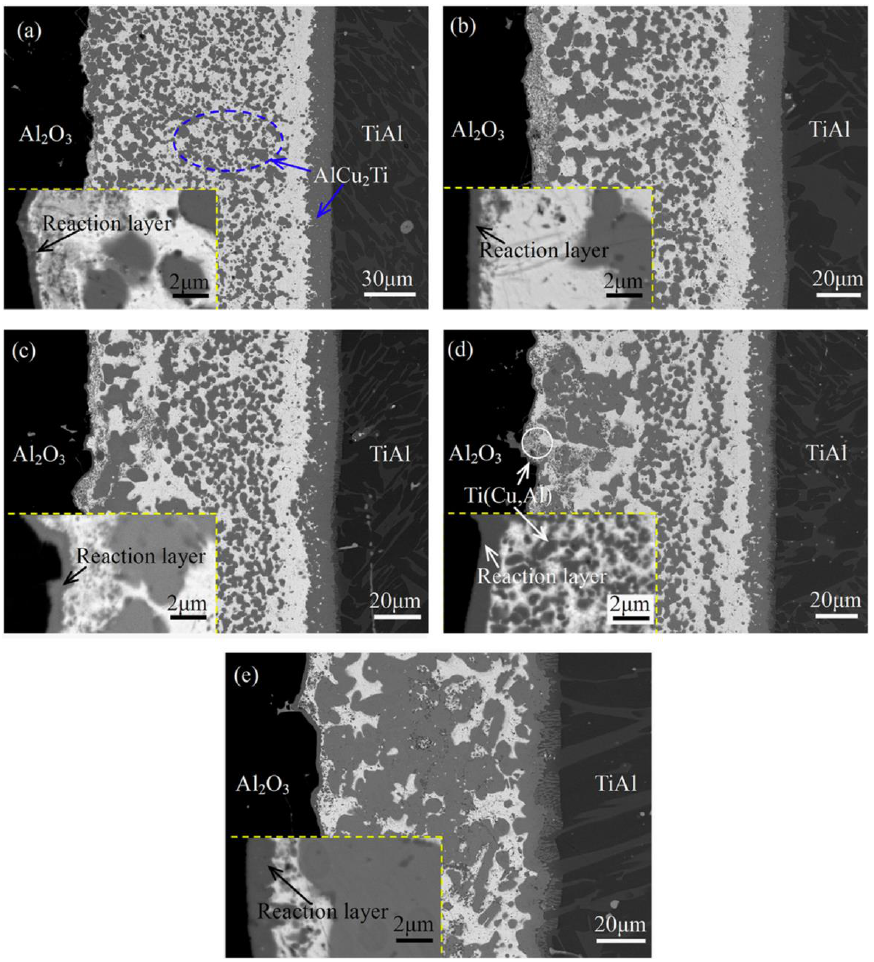
Figure 2. Microstructure of the TiAl/Al 2 O 3 joint brazed at 880 °C for 10 min with different Ti contents: ( a ) 0, ( b ) 2, ( c ) 4, ( d ) 6 and ( e ) 8 wt%, reproduced from Reference [23] with permission of Elsevier,